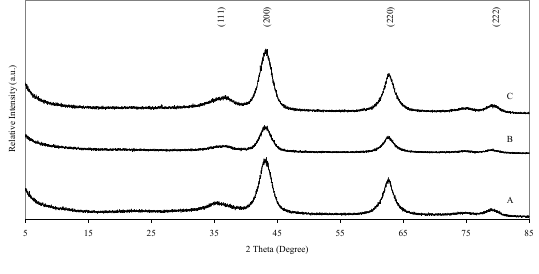
Figure 3. XRD patterns of mixed oxides after calcination original layered double hydroxides at 650ºC. A-Mg/Al Co/Al , C-Mg/Ni/Al Crystalline phase: MgO (Pdf # 75- 65 65. 1525).